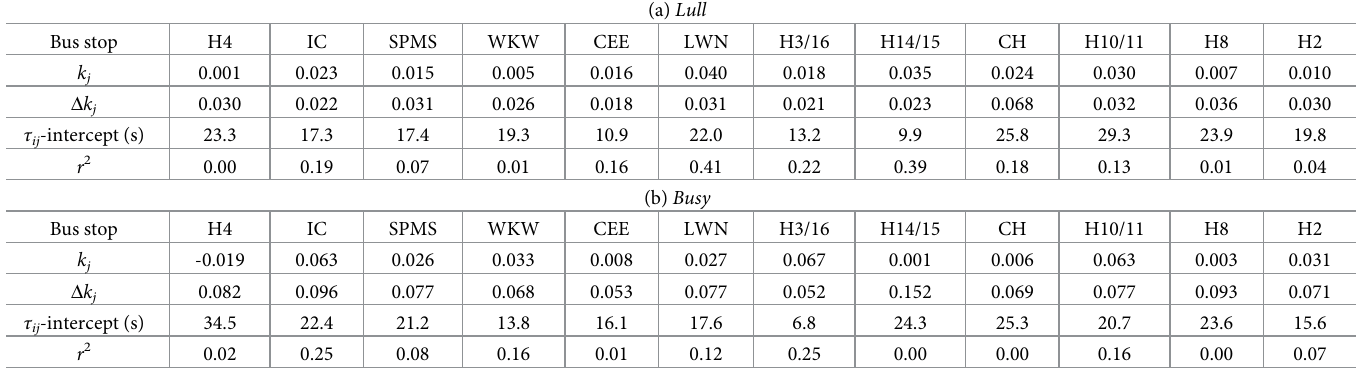
Table 1. (a) The values of k and their errors, for each of the 12 bus stops in the NTU loop campus shuttle bus service, during the lull period (4 pm to 5 pm). These results j are obtained from data measured over the entire working week of 16th to 20th of April, 2018. (b) The corresponding values during the busy period (9 am to 10 am). (a) Lull Bus